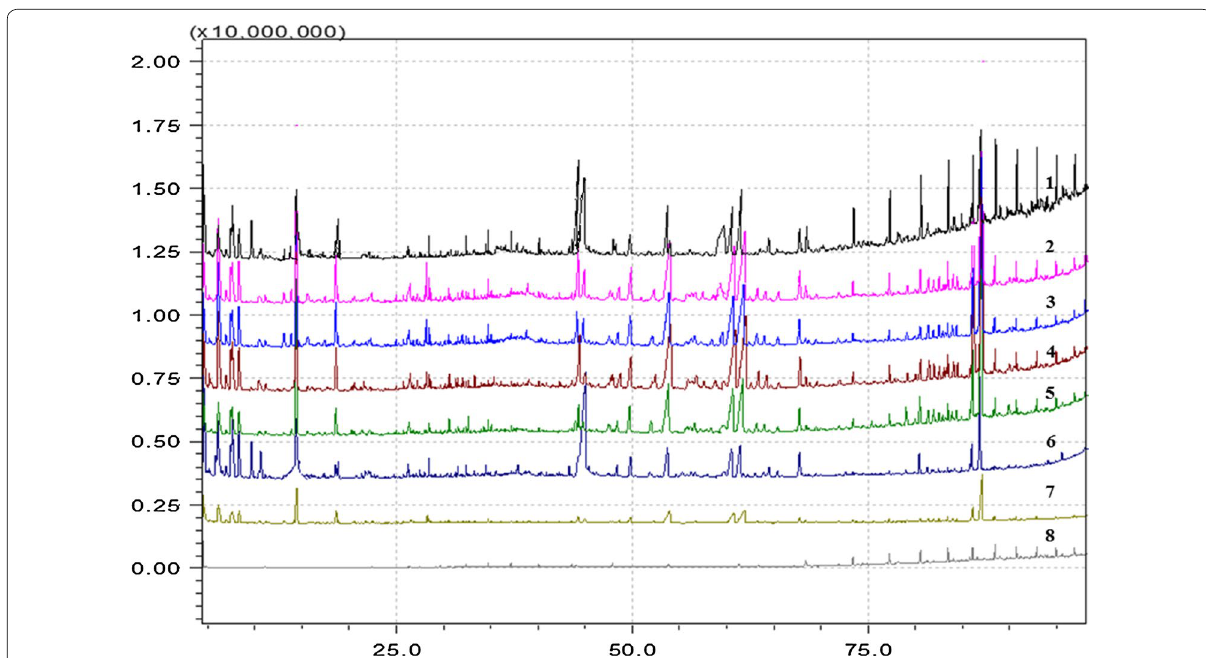
Fig. 1 Representative GC–MS chromatography of chloroform extraction of RV and WV ( 1 RV with 30 months storage time; 2 RV with 20 months storage time; 3 RV with 14 months storage time; 4 RV with 7 months storage time; 5 RV with 5 months storage time; 6 RV with 4 months storage time; 7 RV with 1 month storage time; 8 WV with 24 months storage